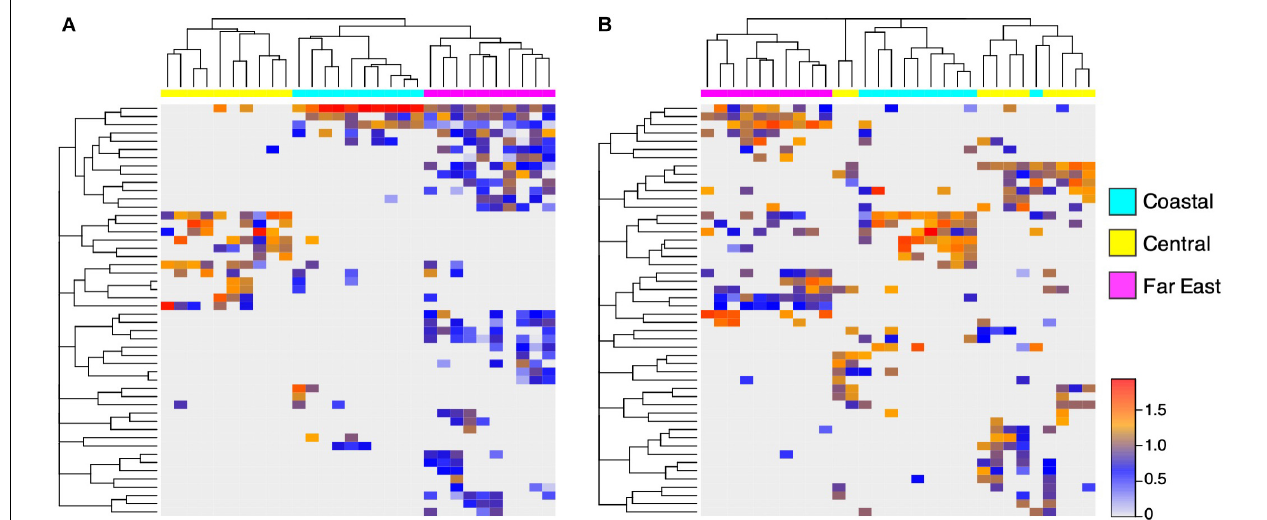
FIGURE 6 | Regional differences in Namib Desert communities. UPGMA-clustered heatmap of 50 (A) Cyanobacteria OTUs and (B) Proteobacteria OTUs with highest proportion of reads, from three sites in the Namib Desert. Rows correspond to OTUs and columns correspond to individual samples. Color scale represents log-normalized relative